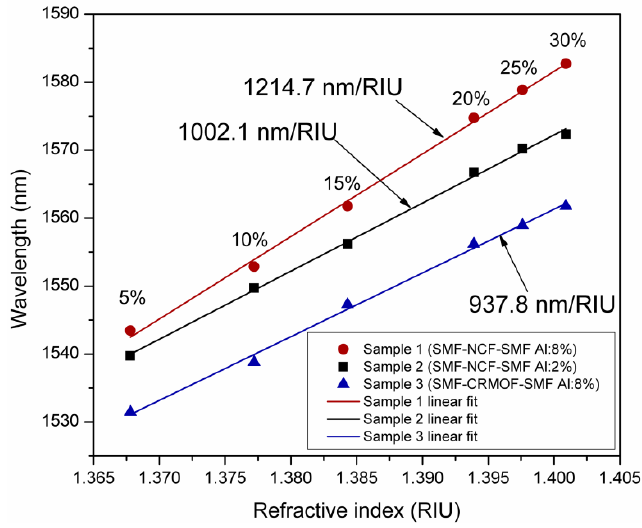
Figure 6. Sensitivity of the coated fiber structures to RI variations of the IPA/glycerin solutions.